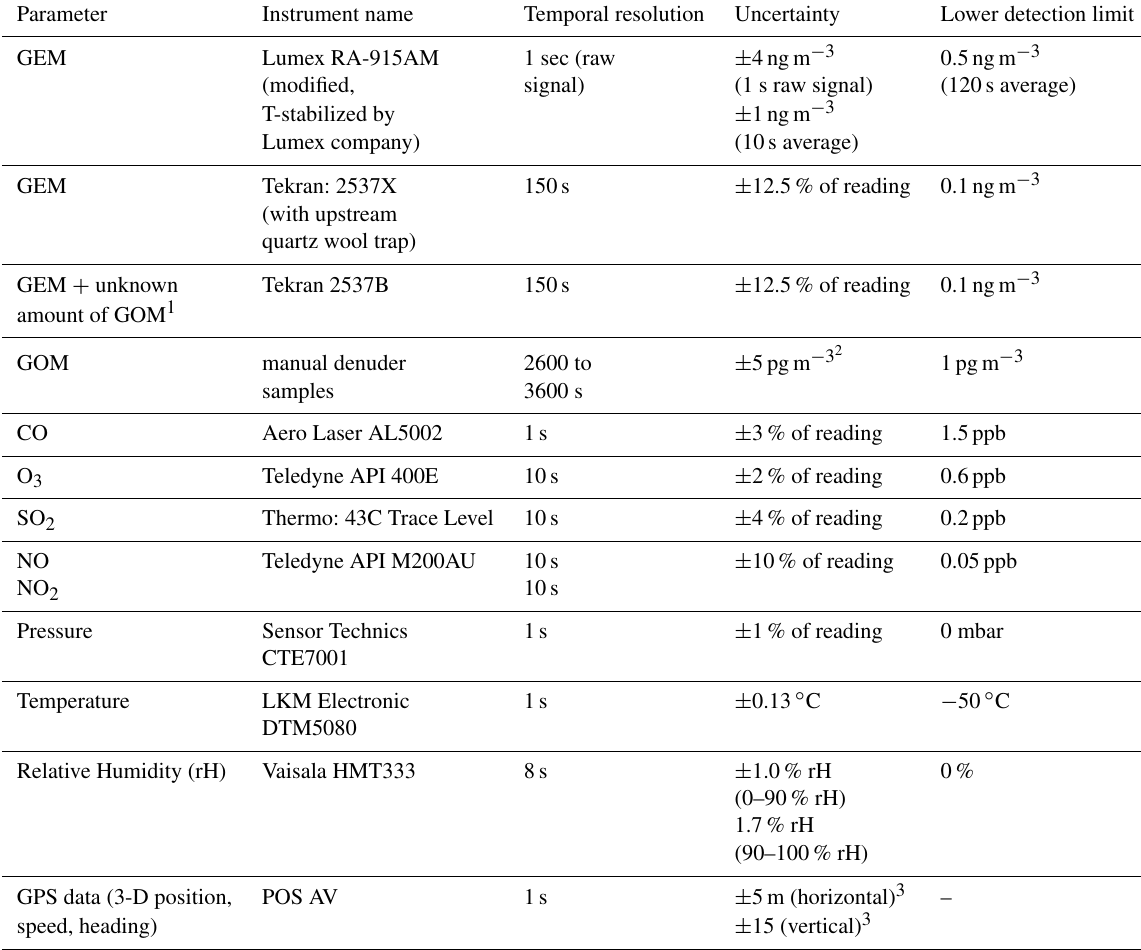
Table 1. List of instruments in the CASA 212 research aircraft. GEM is gaseous elemental mercury and GOM is gaseous oxidized mercury.